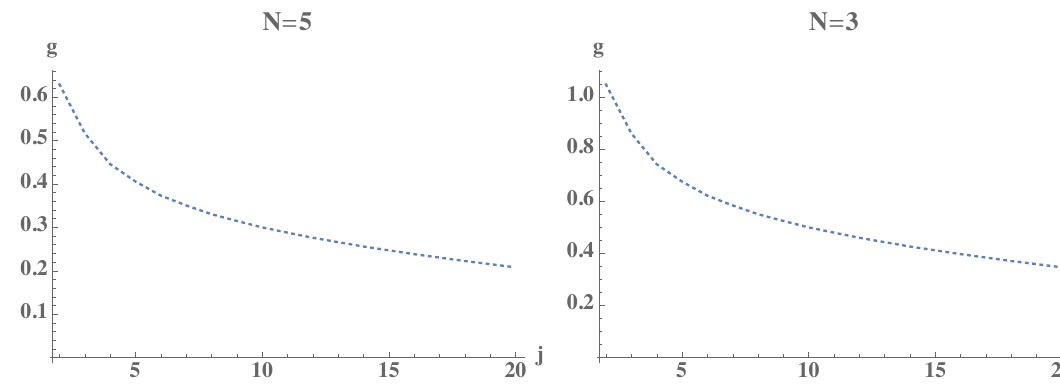
Figure 12. Crossing point for the dimensions of leading and subleading twist operators at (cid:12)nite values of N = 5 and N = 3 as a function of j . The crossing point is given by the intersection of the (Pad(cid:19)e for (cid:12)nite spin twist-two) and the (Pad(cid:18)e for